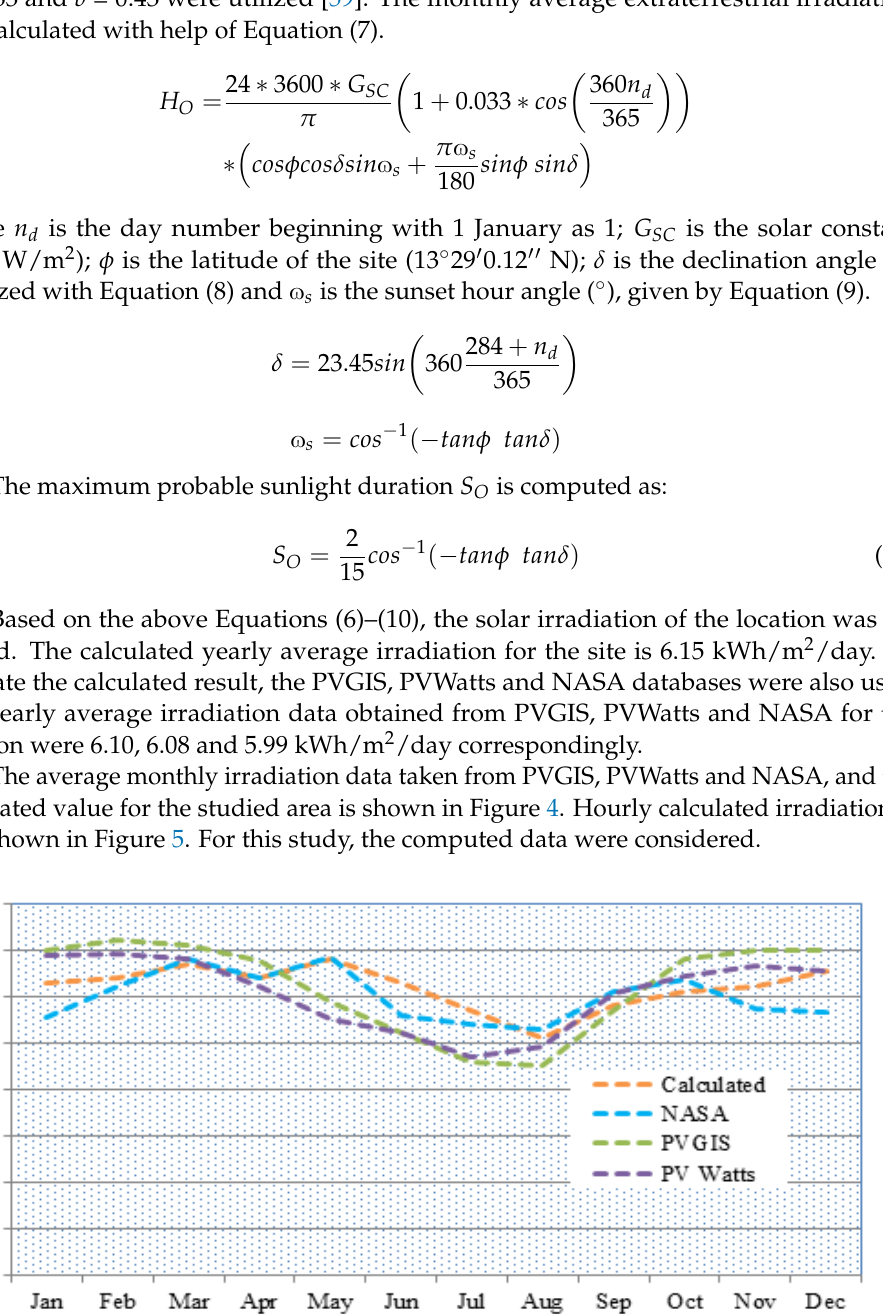
Figure 5. Calculated hourly solar radiation, kW h/m 2 . To obtain the real power output from solar PV power, recognizing the ambient tem- perature of the site is very essential. Figure 6 indicates the average monthly temperature